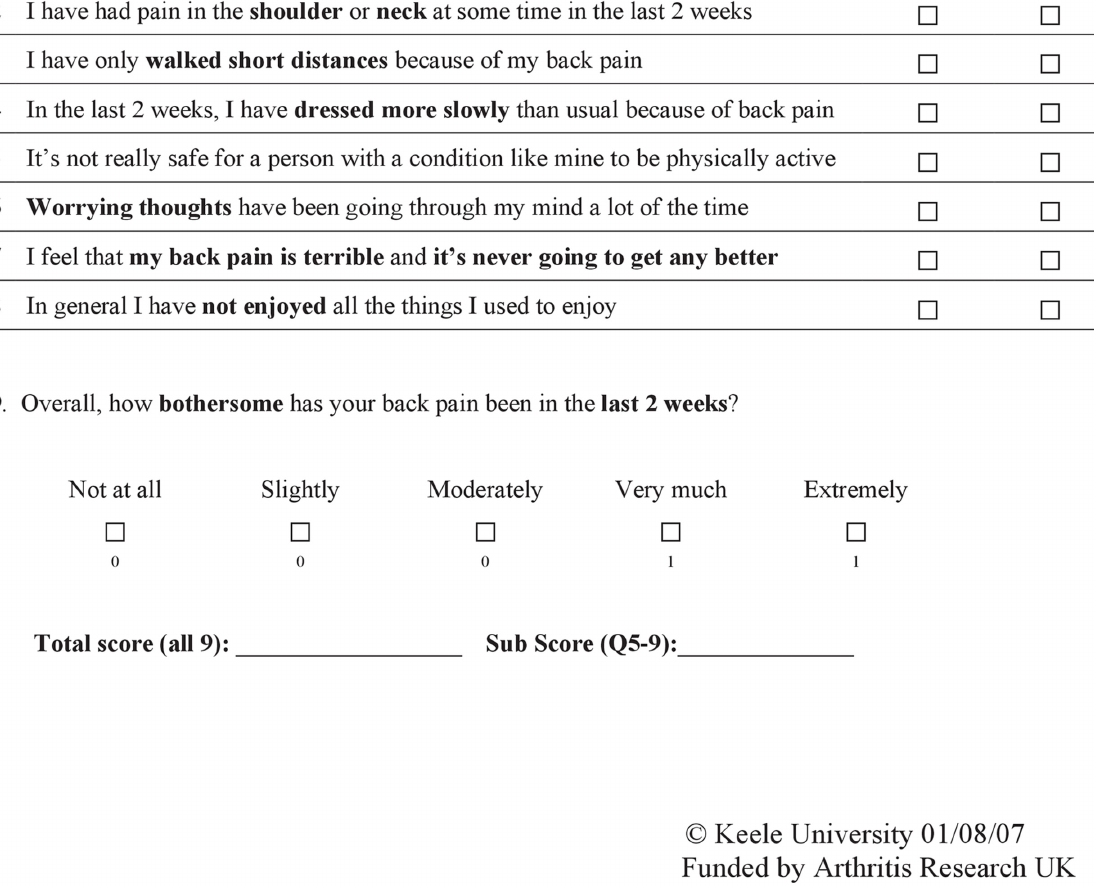
PLOS ONE | DOI:10.1371/journal.pone.0152019 March 22, 2016 3 /